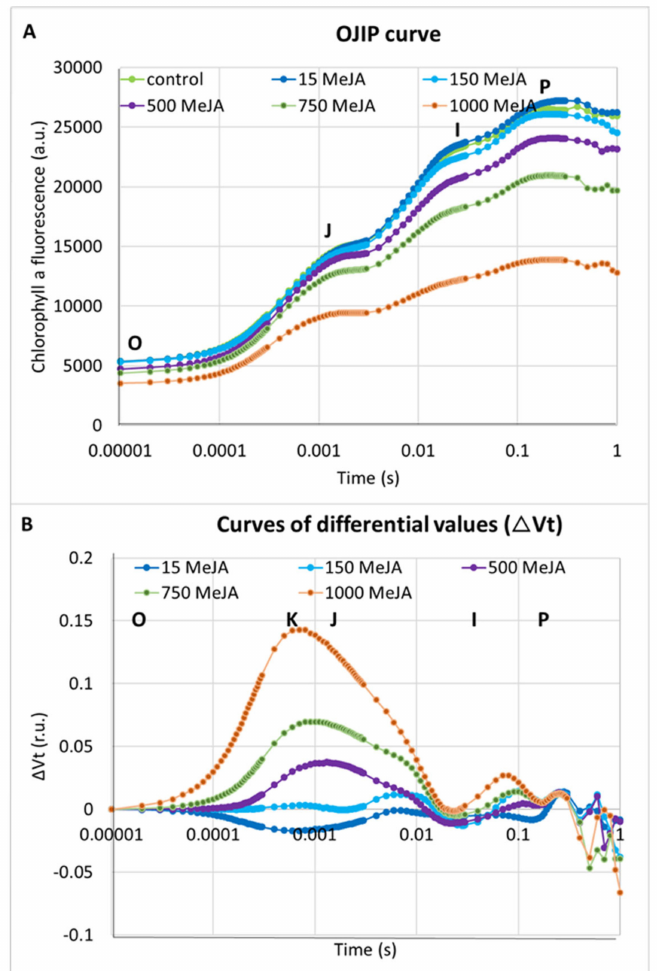
Figure 2. The e ff ect of di ff erent concentrations of MeJA on the photosynthesis e ffi ciency in seedlings of barley cv. ‘Sebastian’: ( A ) OJIP induction curves after treatment with MeJA; and ( B ) di ff erences in the relative variable fluorescence of the O-P-normalised induction curves ( ∆ Vt) after MeJA treatment. The values are presented as the means ± SD, ten plants per one biological replication, three biological replications were used. The ∆ Vt curves were constructed by subtracting the normalised fluorescence values (between O and P) recorded in control conditions from those recorded after MeJA